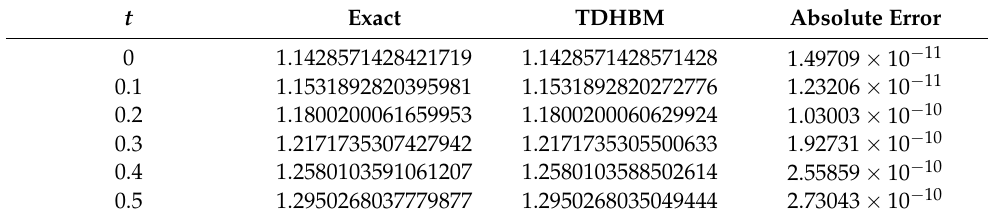
Table 2. Numerical results for Problem (22) with h = 0.1.